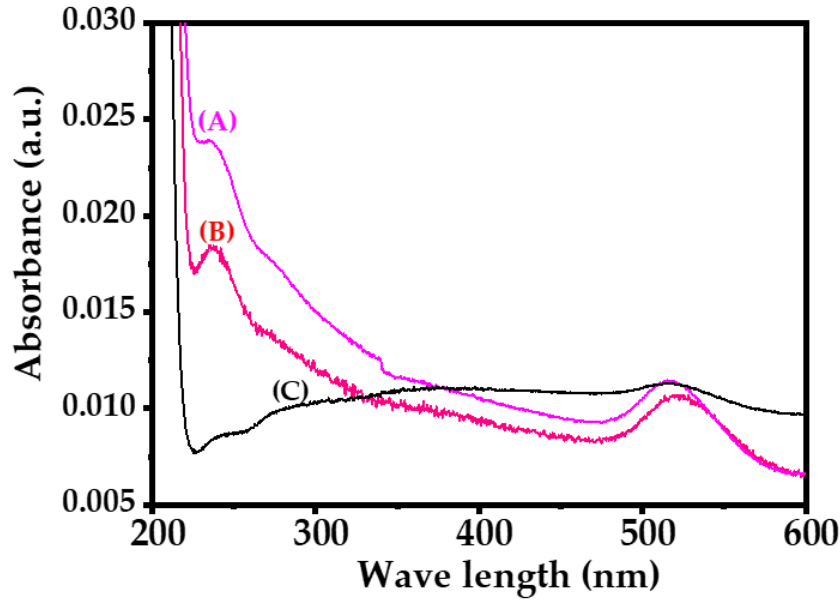
Figure 3. The UV-visible spectroscopy of GNPs: A, GNPs-1; B, GNPs-2; and C, GNPs-3.